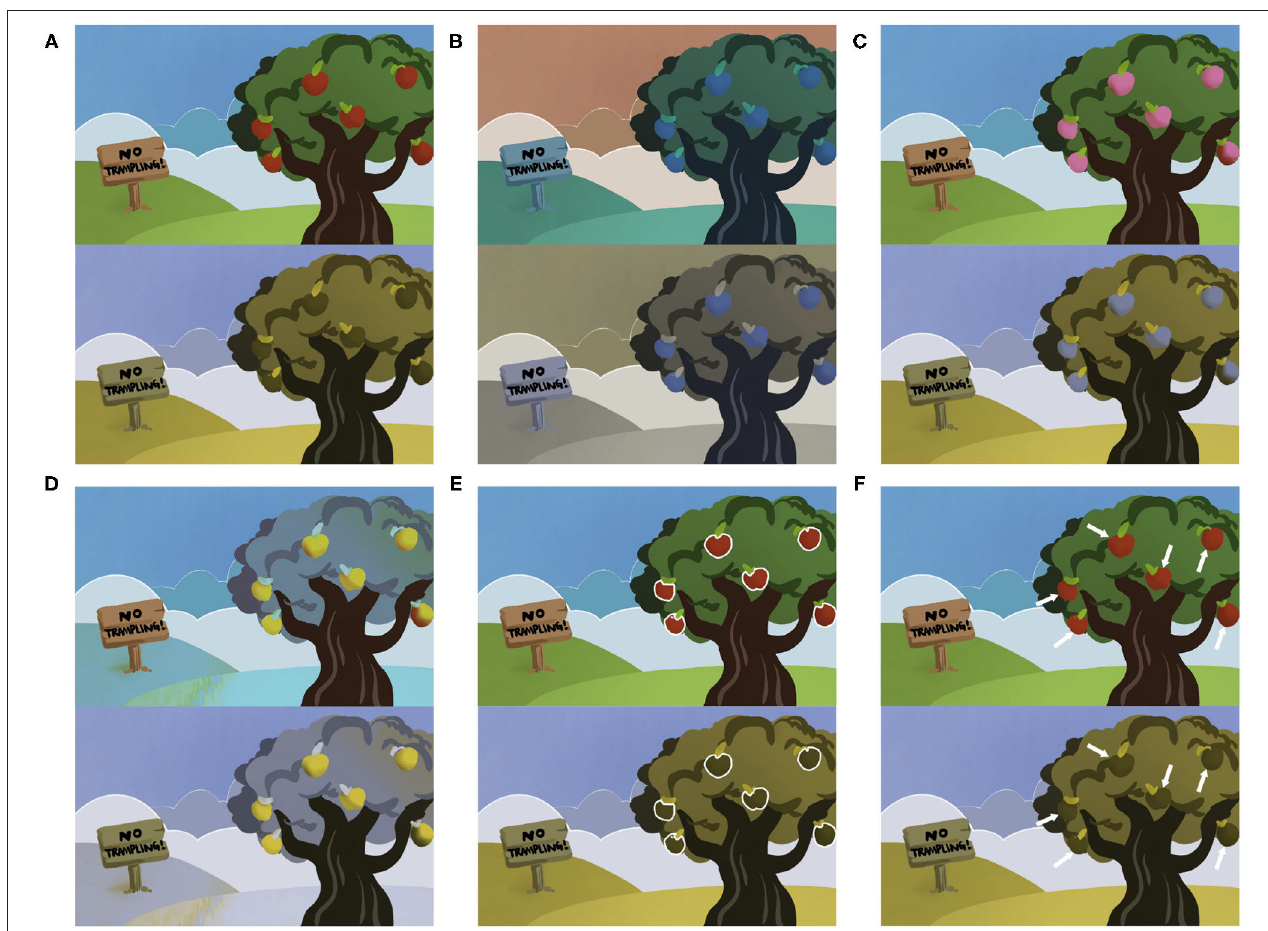
FIGURE 3 | Different methods to help patients with color blindness. The top figure indicates healthy vision in each pair of figures, while the bottom indicates patients with protanopia. (A) The natural scene. The patients with protanopia cannot distinguish the apples in red and the leaves in green. (B) The daltonization method (27). All colors are shifted to achieve less confusing color combinations. (C) The highlight method ( 26). Once the patients want to distinguish any color, the target color will be replaced by other colors that are easier to distinguish. In this case, red is replaced by pink. (D) The contrast method ( 26). In this case, red is replaced by yellow, and green is replaced by blue. (E) The outline method (26). In this case, the areas in red are outlined in order to be distinguished easily. (F) The method of using icons (30). In this case, the areas in red are indicated by the